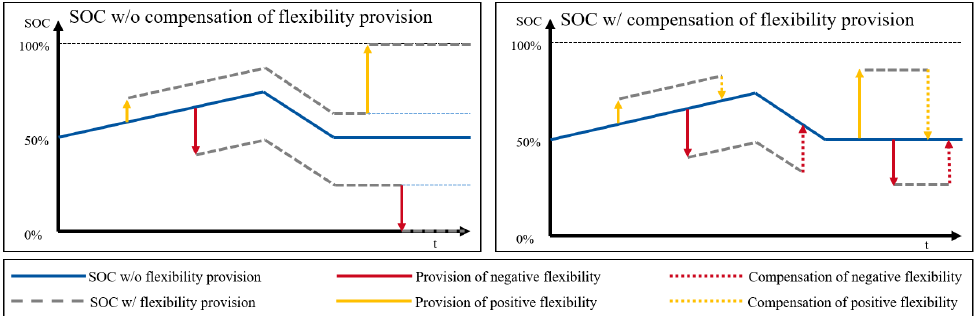
Figure 3. Available flexibility of storage systems (based on either positive or negative activation) with and without compensation